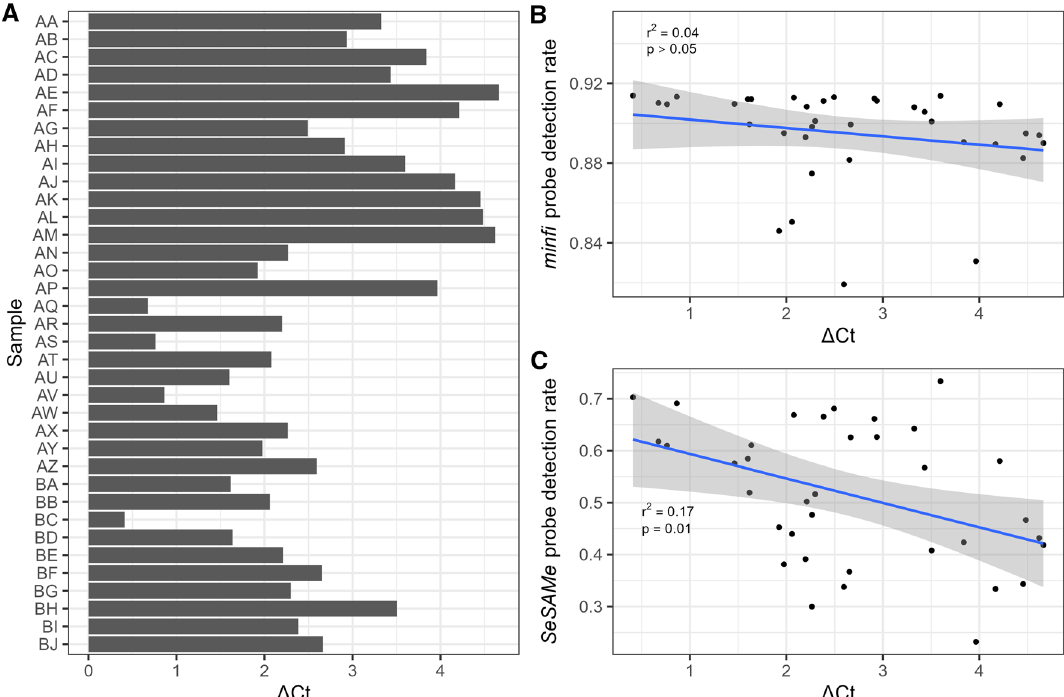
Figure 2. Infinium QC measurements of the DNA quality (ΔCt). ( A ) ΔCt values of each sample. ( B ) Correlation between ΔCt and minfi probe DR. The equation of the best fitting linear model was: